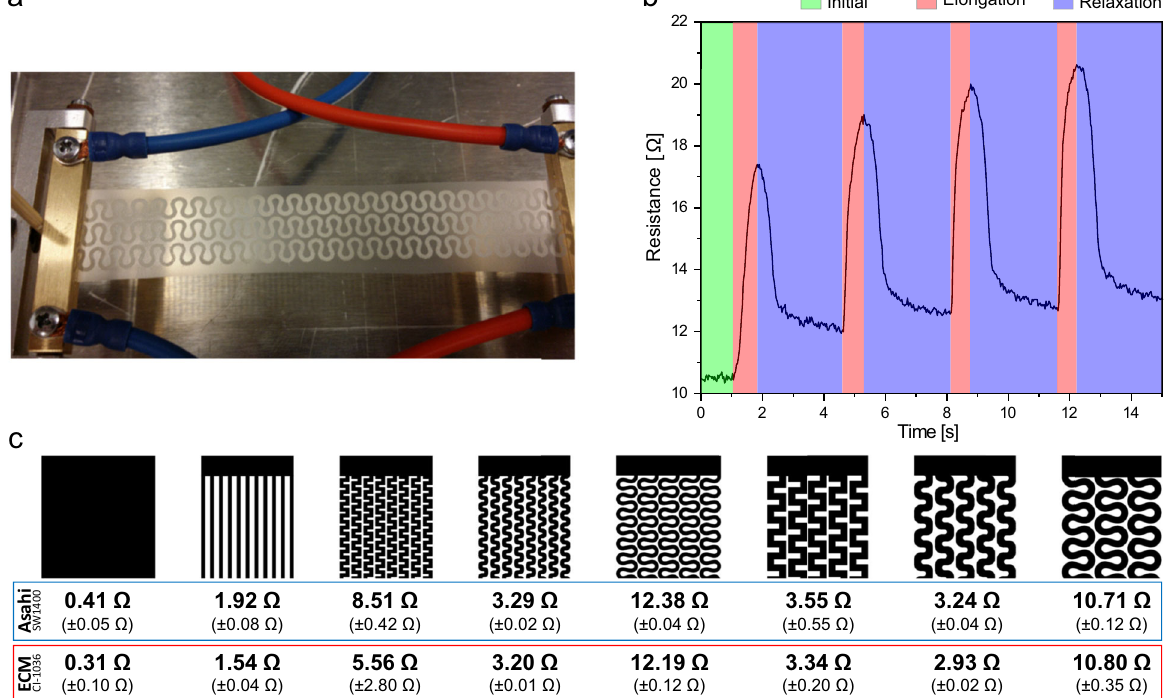
Fig. 2 Resistance measurements. a Four-probe resistance vs. elongation measurement system with 30 Hz sampling rate. b An exemplary plot of the electrode resistance variation during the elongation cycling. c The initial resistance of the various shaped electrodes for Asahi SW1400 and ECM CI-1036 screen-printing